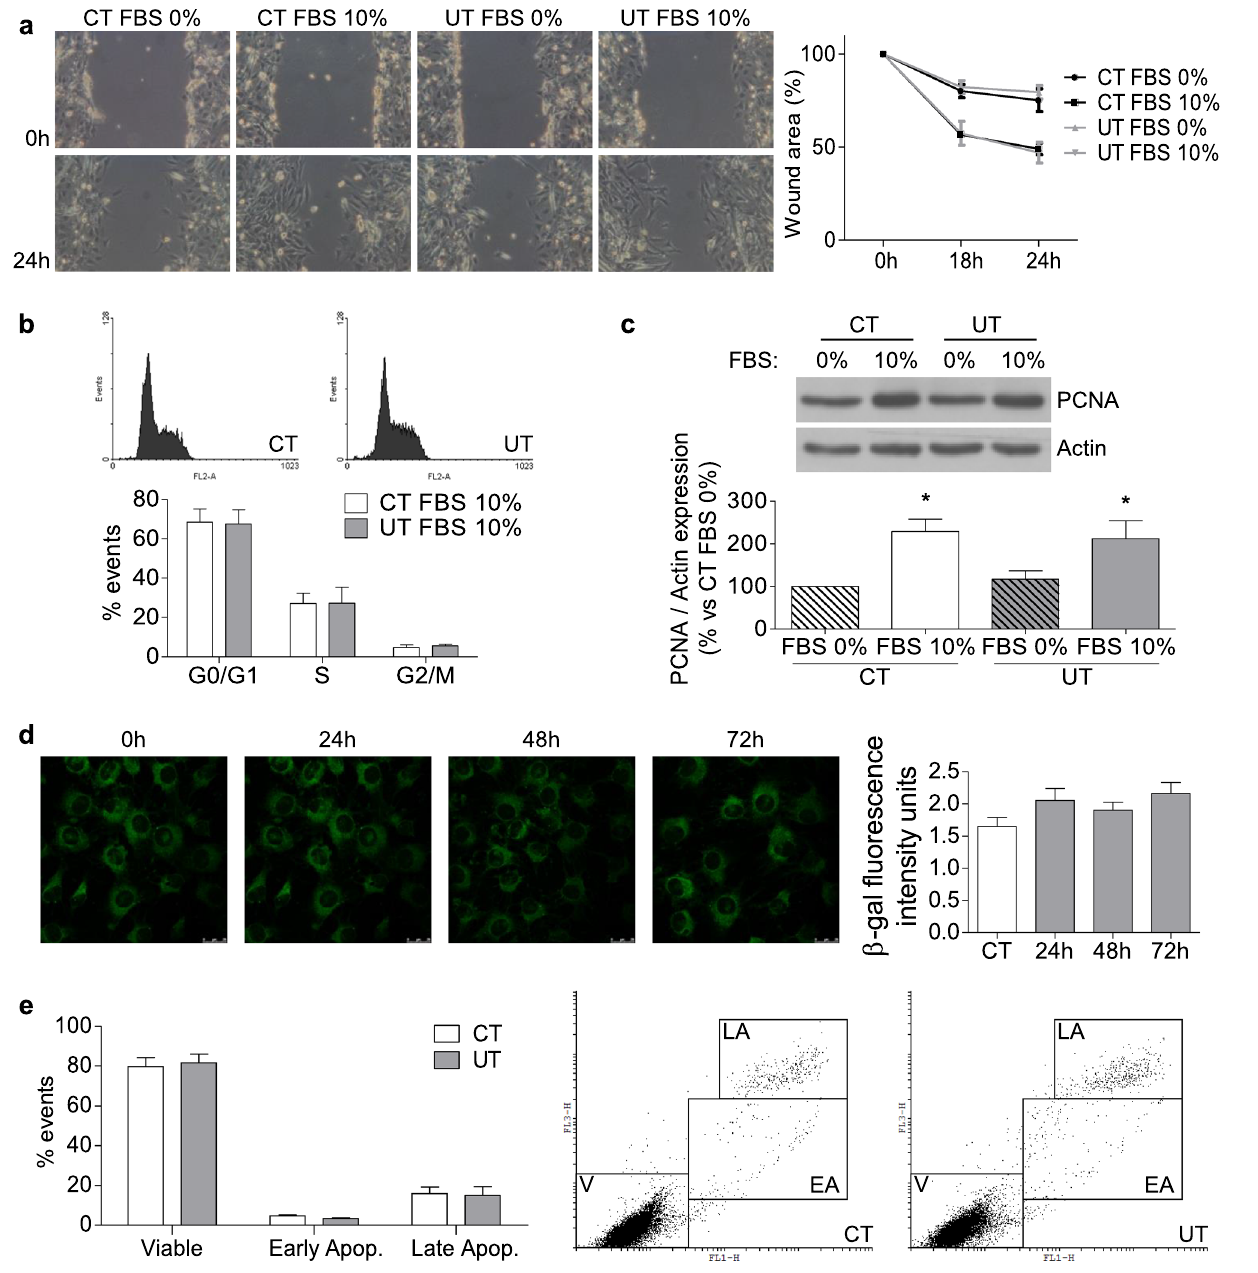
Figure 4. Low doses of UT did not change either the cell cycle or cellular senescence in murine cultured myoblasts. C 2 C 12 cells were treated with a mixture of 25 µg/mL IS and 10 µg/mL PC (UT) or vehicle (CT) for 48 h. ( a ) Scratch wounding was made in the confluent monolayer and wound closure was monitored over the next 24 h with or without 10% FBS. Wounds were photographed at 0, 18, and 24 h after wounding to measure the degree of wound closure. A representative experiment shows only the photographs taken at 0 and 24 h after wounding. The graph represents the percentage of wound closure with respect to time 0 h. The results showed are mean ± SEM from five experiments. ( b ) C 2 C 12 cells were treated for 48 h in culture medium with 10% FBS. Propidium iodide incorporation was assessed by flow cytometry. A typical experiment is shown. Results are the mean ± SEM from four experiments. ( c ) C 2 C 12 cells were treated for 48 h with or without 10% FBS. PCNA expression was analysed by western blotting. A typical blot is shown. Full-length blot is presented in Supplementary Figure S3. The bar graph shows the densitometric analysis of the bands. The results, expressed as a percentage of control, are the mean ± SEM from seven different experiments. * p < 0.05 versus CT FBS 0%. ( d ) C 2 C 12 cells were treated for 24, 48, or 72 h. Senescence-associated β-galactosidase activity was measured by confocal microscopy with the fluorogenic substrate C 12 FDG. A typical experiment is shown. Results showed in the bar graph represent mean ± SEM from ten experiments. ( e ) C 2 C 12 cells were treated for 48 h. Apoptosis was analysed using the Annexin V test via flow cytometry. A typical experiment is shown. Results are the mean ± SEM from six